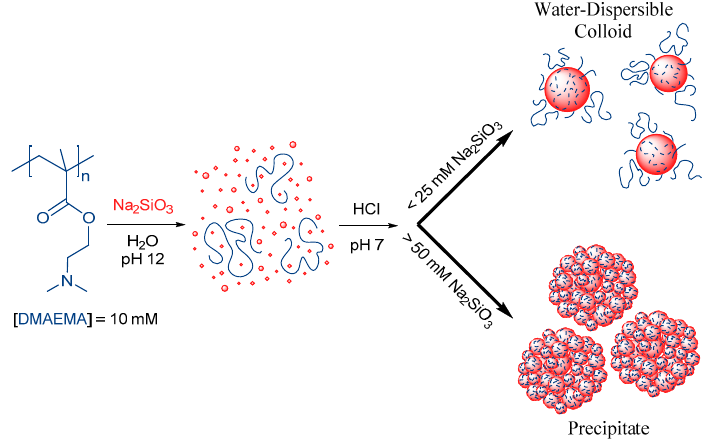
Figure 10. Acid-triggered hydrolysis of sodium silicate (Na 2 SiO 3 ) and subsequent polycondensation of silicic acid (Si(OH) 4 ) is directed by polycation bearing DMAEMA repeating units. The resultant silica-polyelectrolyte (S-PE) nanocomposites either precipitate or form water-stable (dispersible) particles, depending on the initial concentration of the sodium silicate precursor with respect to the (10 mM) concentration of DMAEMA repeating units.